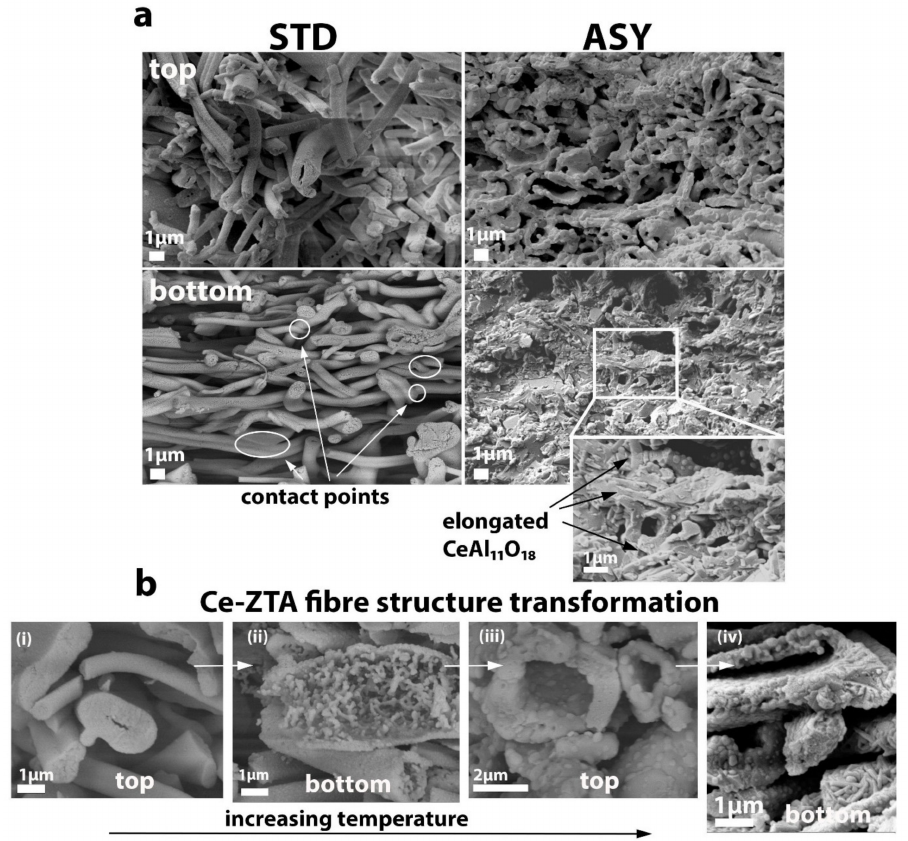
Figure 8. Comparative SEM micrographs of ( a ) the top and bottom sides of the fractured surface of the CE-ZTA samples fabricated in an STD and ASY graphite arrangement at a 1300 ◦ C sintering temperature, and ( b ) the Ce-ZTA fibre structure transformations fabricated in ASY; (i) and (ii) are sintered at 1200 ◦ C, whereas (iii) and (iv) are at 1300 ◦